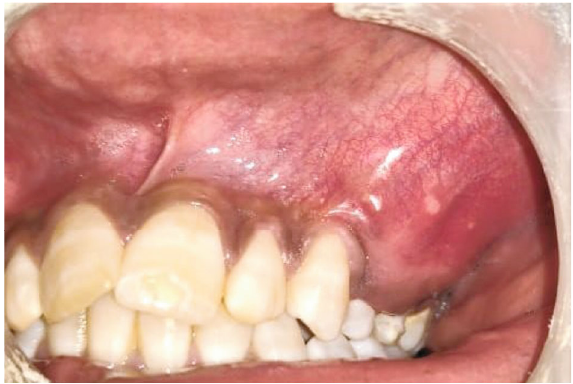
Figure 1: Intraoral view of the lesion.